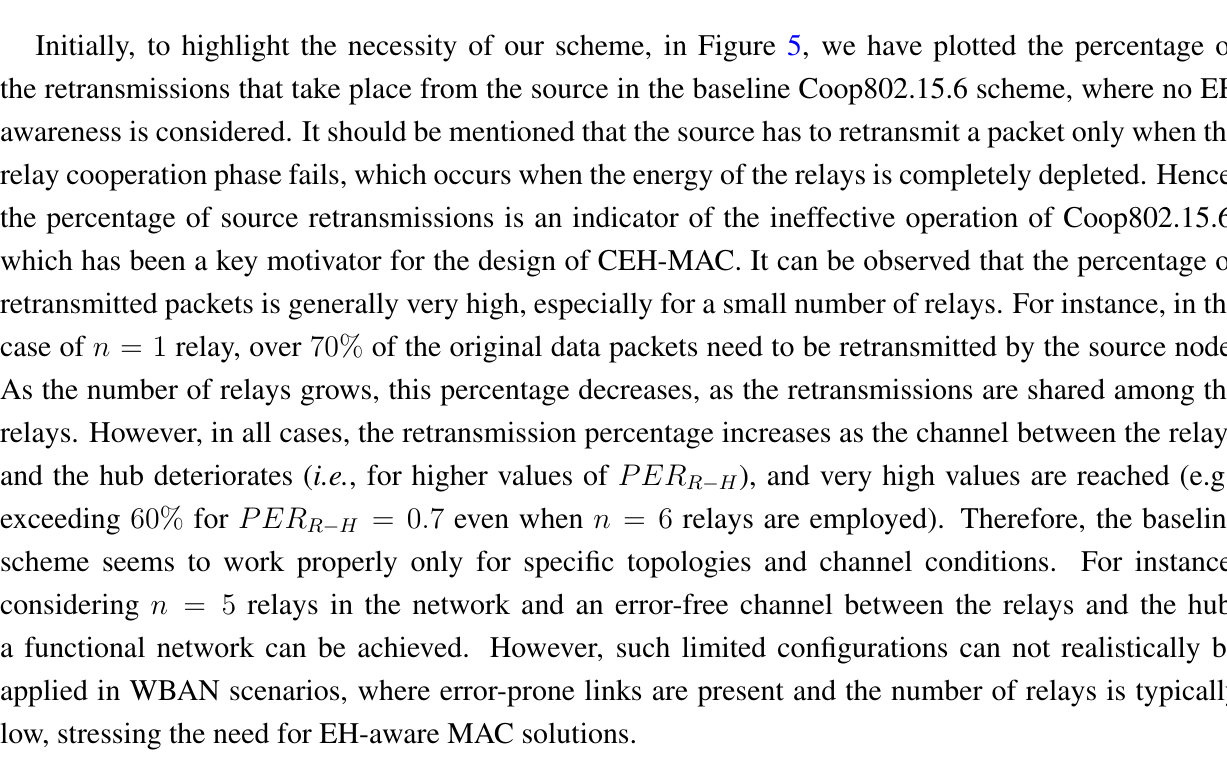
) regression analysis. ( a ) n = 1 ; ( b ) n > 1 adj